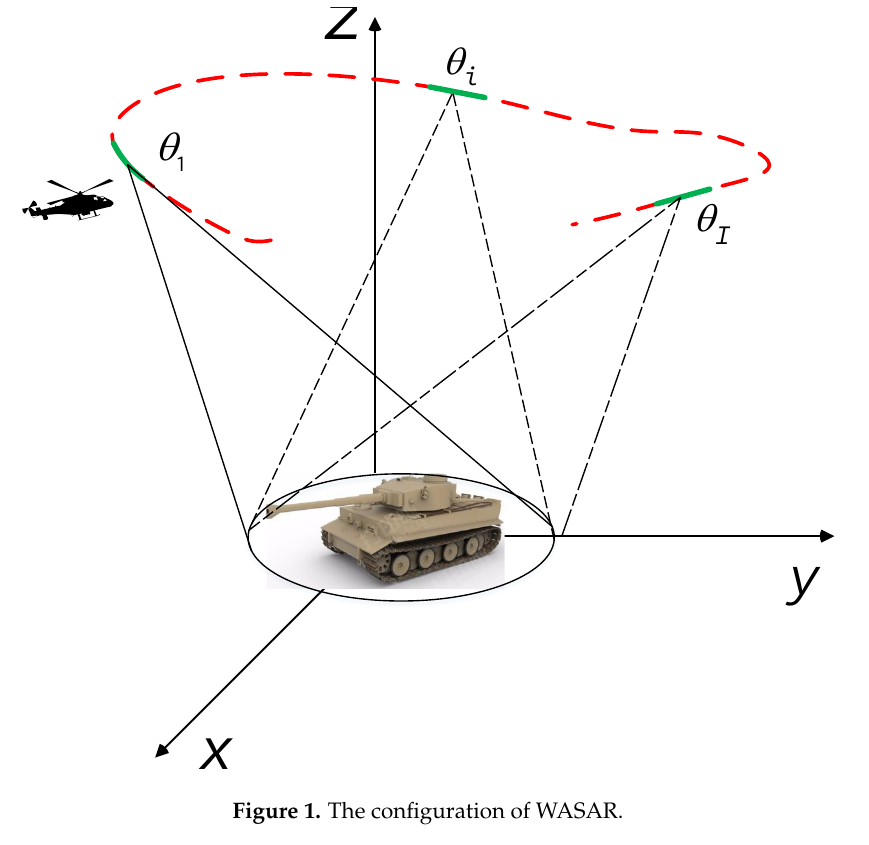
Figure 1. The configuration of